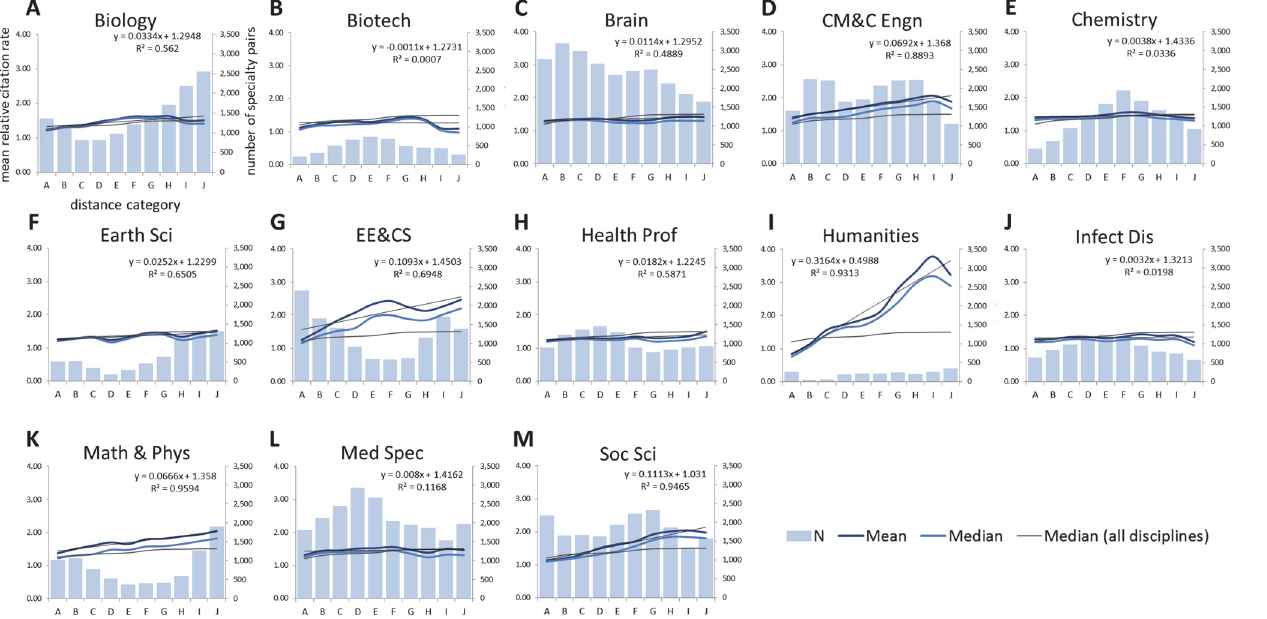
Fig 3. Number, mean and median relative citation rate of subdiscipline pairs across distance categories per